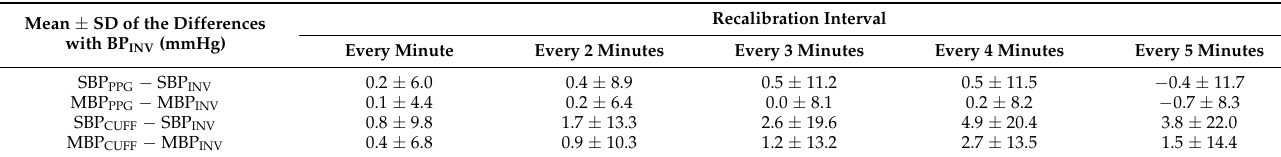
Table 2. Resulting mean and SD of the error for both BP PPG and BP CUFF .